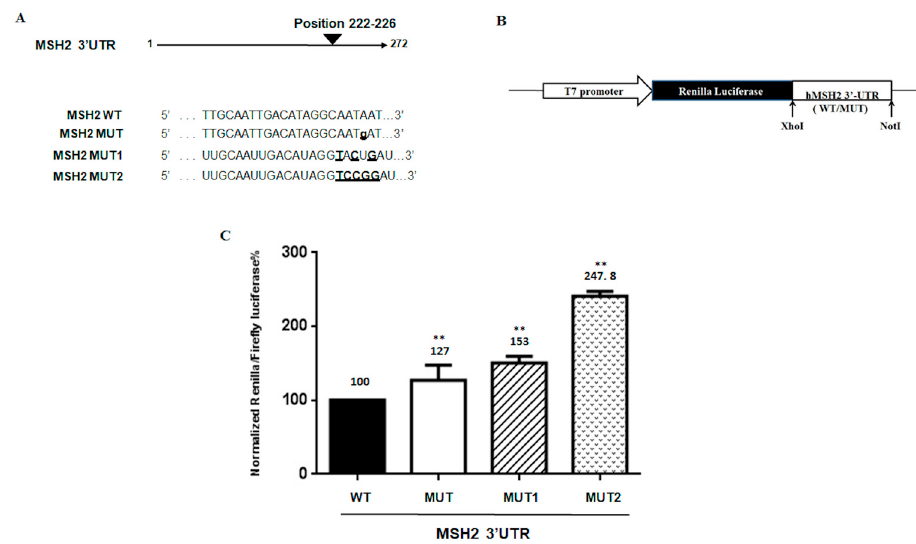
Figure 5. Luciferase MSH2 3’UTR constructs and reporter assay. ( A ) Sequences of wild type and mutant in the 3’UTR of MSH2 of reporter constructs are shown. The mutated bases are underlined. ( B ) Schematic diagram of the luciferase reporter gene constructs. The constructs were cloned into the PSICHECK2 vector as indicated in Materials and Methods. ( C ) Luciferase activities of reporters carrying the wild type (WT) and mutated (MUT, MUT1, MUT2) MSH2 3’UTR were measured in SW480 cells. The data were normalized to the Firefly luciferase activity. Values are expressed in percentage as the mean ± SD of five determinations for samples assayed in three independent experiments. ** Statistical significance was determined by one-way ANOVA ( p -value < 0.005).